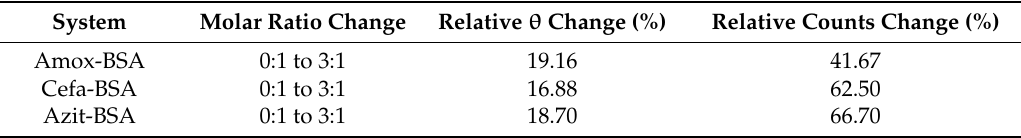
Table 3. Sensitivity comparison between conductive atomic force microscopy (CAFM) tests and circular dichroism (CD) tests.